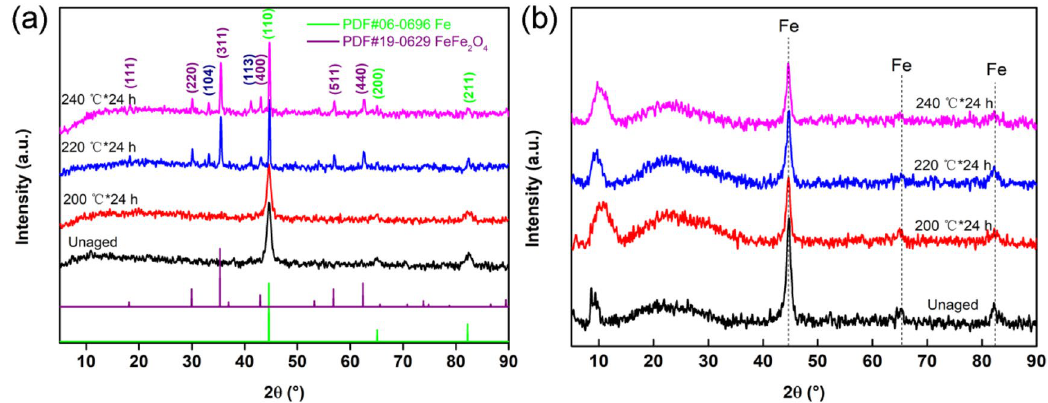
Figure 3. XRD curves of the composites aged at different temperatures: CIPs ( a ) and the MVPQ/CIPs/GR composites ( b ) before and after thermal